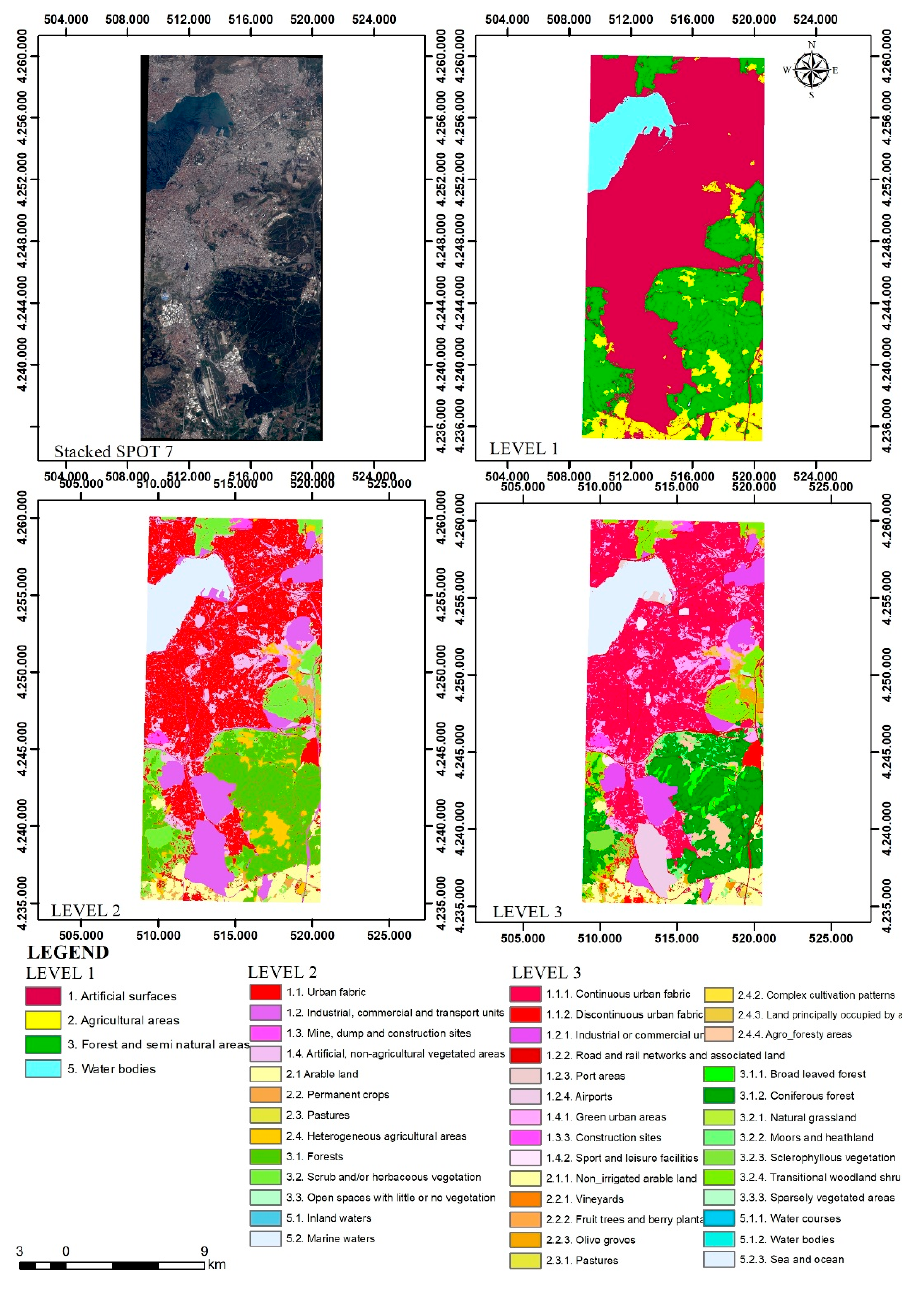
Figure 4. Classification results.